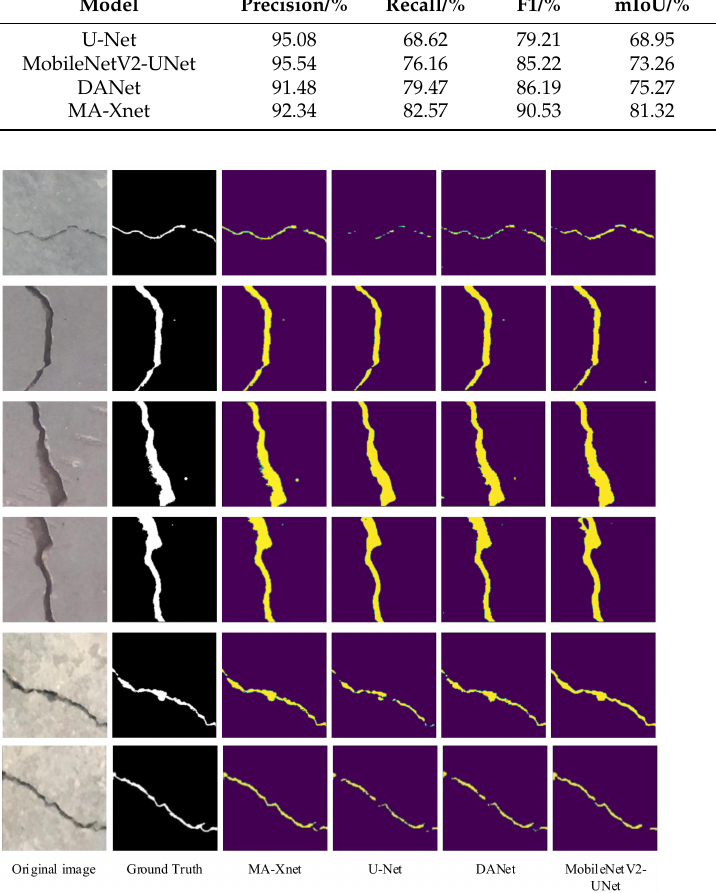
Figure 8. Contrast experiment